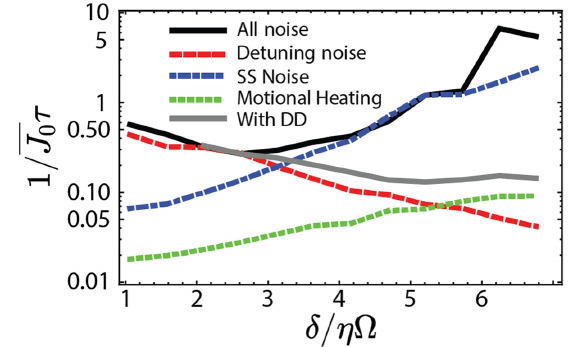
FIG. 6. The relative contributions of the error terms in our noise model. As δ increases, the detuning noise decreases while the Stark-shift noise and the motional heating errors increase. Dynamical decoupling effectively mitigates the Stark-shift noise while having little effect on the other noise sources.